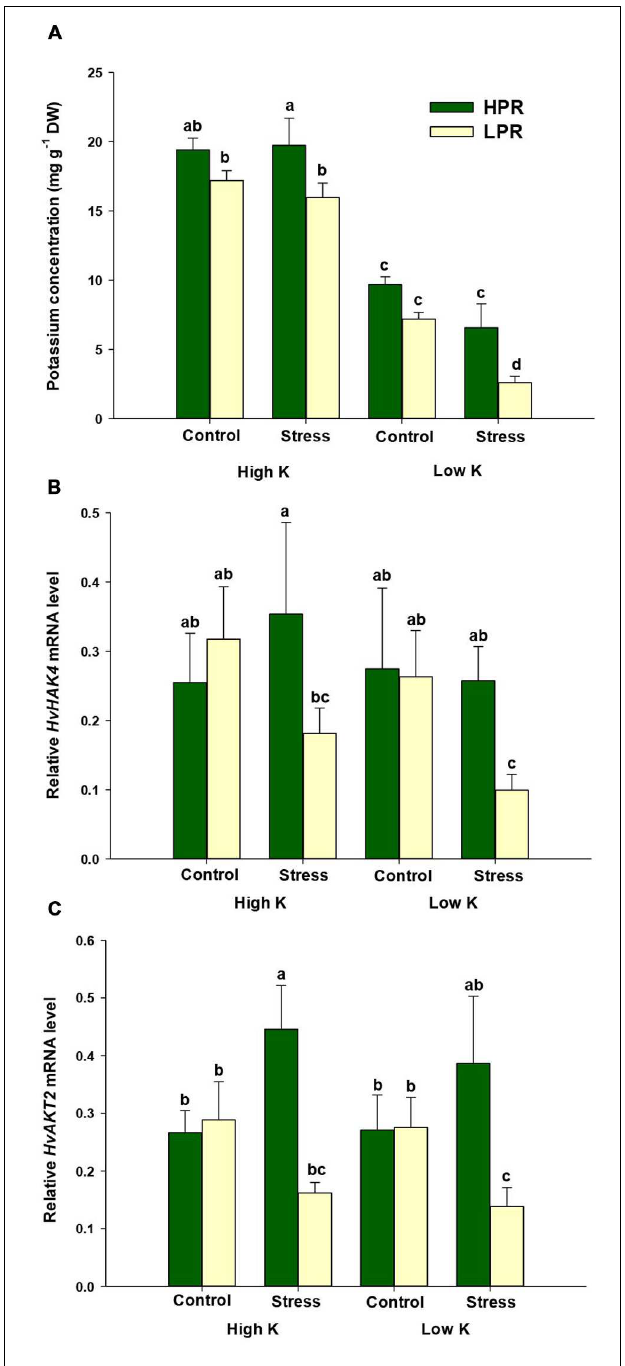
FIGURE 2 | Influence of K supply on K concentrations and gene expression of K transporters in flag leaves of barley during terminal drought stress. (A) K concentrations, (B) relative HvHAK4 mRNA levels, and (C) relative HvAKT2 mRNA levels in flag leaves of the lines HPR and LPR. Plants were pre-cultured under sufficient water supply (control) or water limitation (stress) and under low or high K supply. Flag leaves from 12 weeks-old plants were harvested 12 days after imposing drought stress. Bars indicate mean ± SD. Different letters denote significant differences according to three-way ANOVA and Tukey’s test ( p < 0.05; n = 6). Ubi E2-17 (ubiquitin-conjugating enzyme) was used as reference